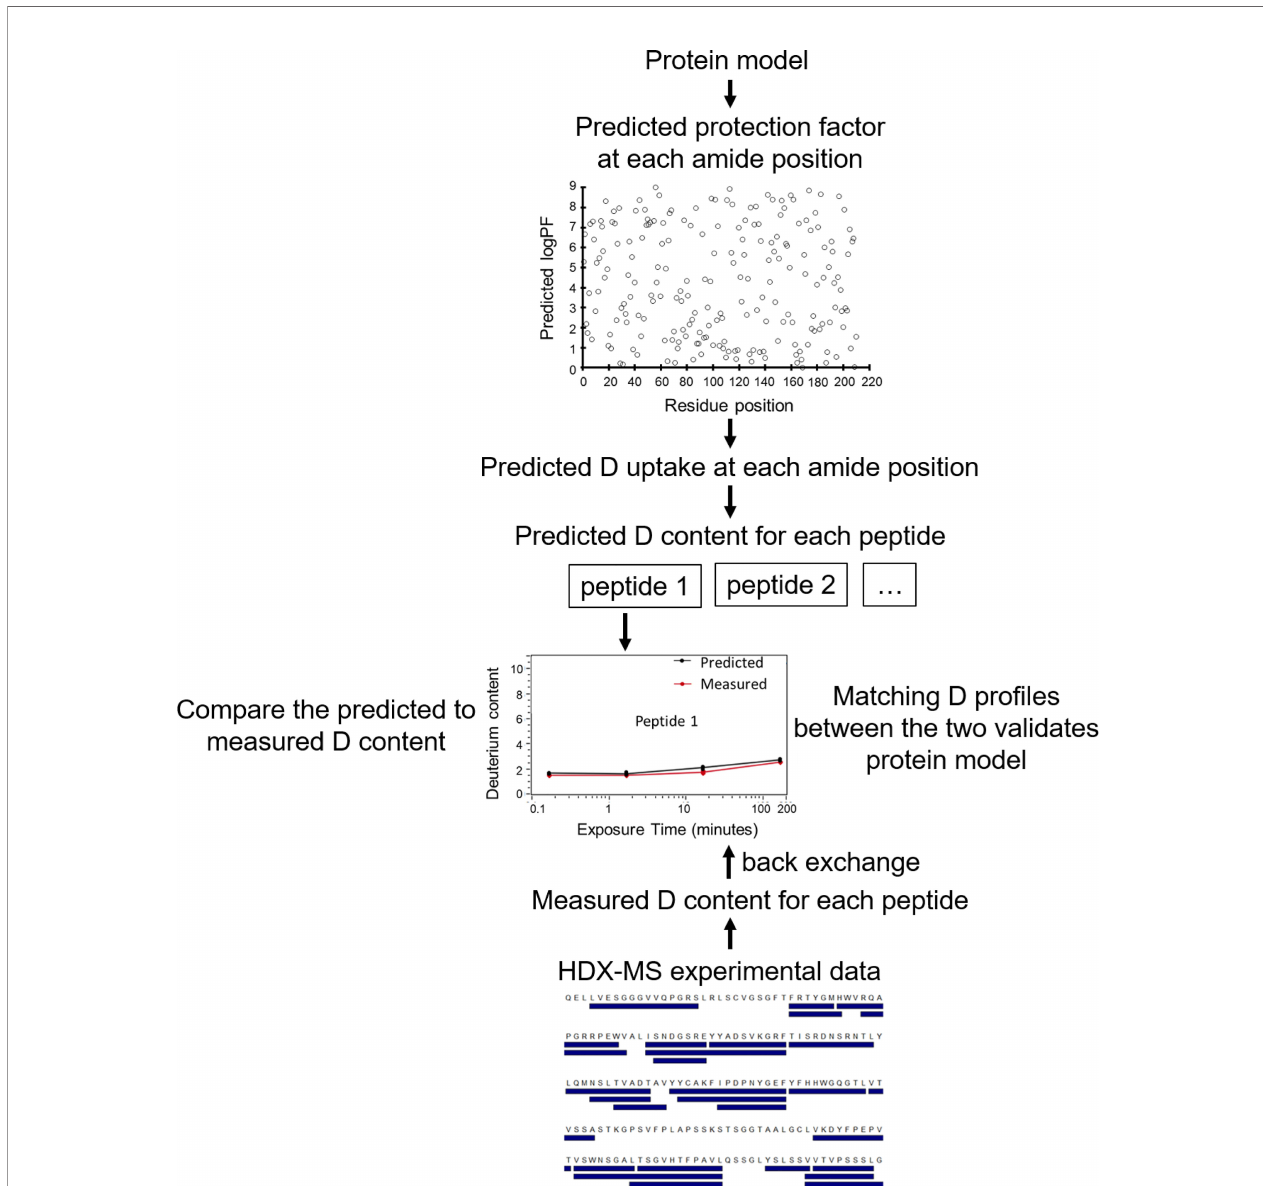
FIGURE 4 | Flowchart of HDX-MS data simulation to validate plausible protein models. For each protein model, PF at each amide position is predicted. From PF and the intrinsic exchange rate k ch , the D value of each residue is calculated. HDX-MS data for each peptide (from the experimental peptide list) is generated by summing D uptake of the member residues. The simulated HDX-MS pro fi les of protein models are compared with the experimental data normalized for back exchange. Matching D pro fi les of multiple peptides validates the protein model, facilitating differentiation between native and non-native